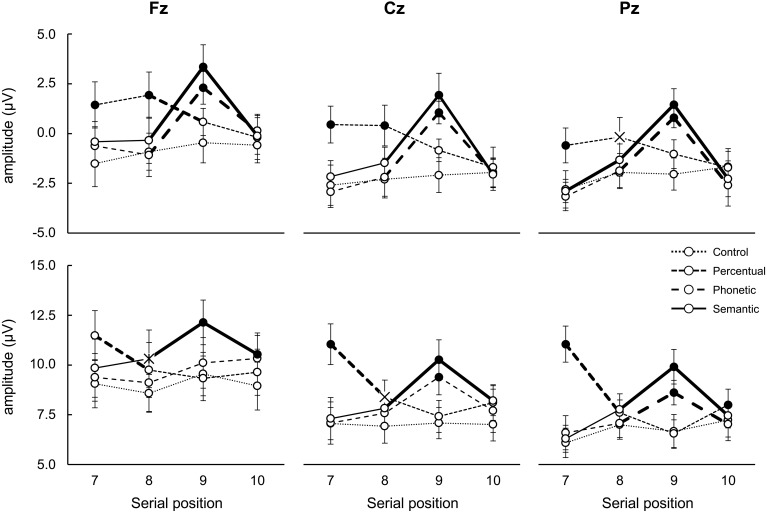
Mean amplitude variation (μV; ±SE) relative to latency time-intervals 350–450 ms (upper panel, containing N400) and 400–800 ms (bottom panel, containing P300 and PSWs) according to electrode, serial position and list type. Bold lines indicate difference between adjacent serial positions; filled circles () indicate difference between lists in the same serial position; X indicates different from control lists only. See text for detailed statistical results.